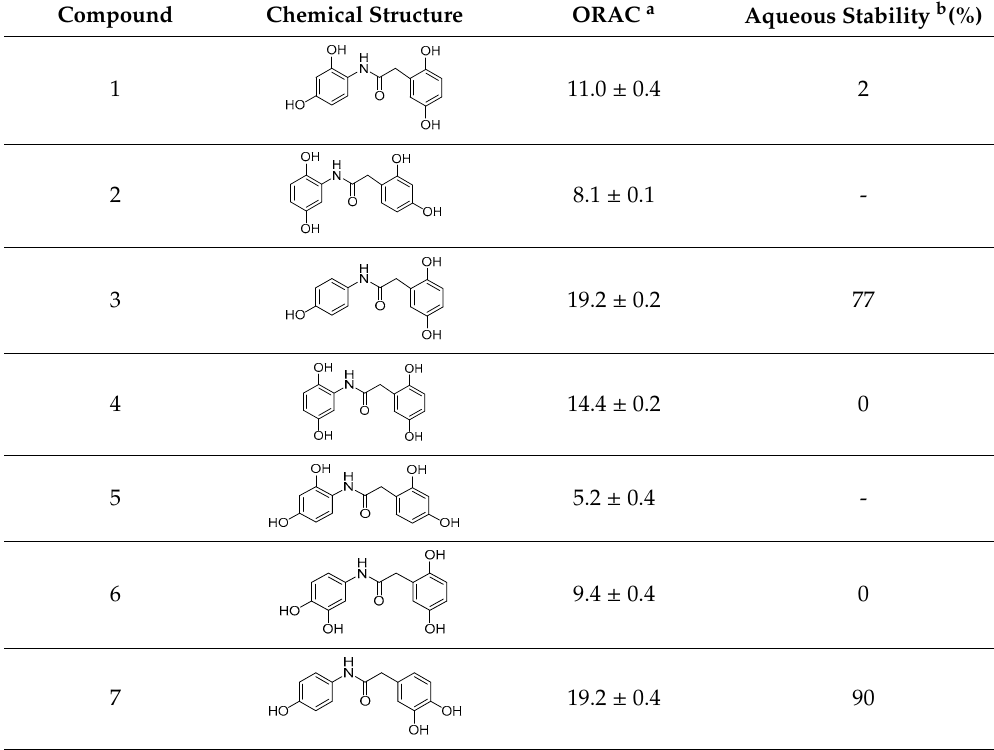
Table 3. Antioxidant activity (oxygen radical absorbance capacity (ORAC)) and chemical stability of compounds 1 to 18 .